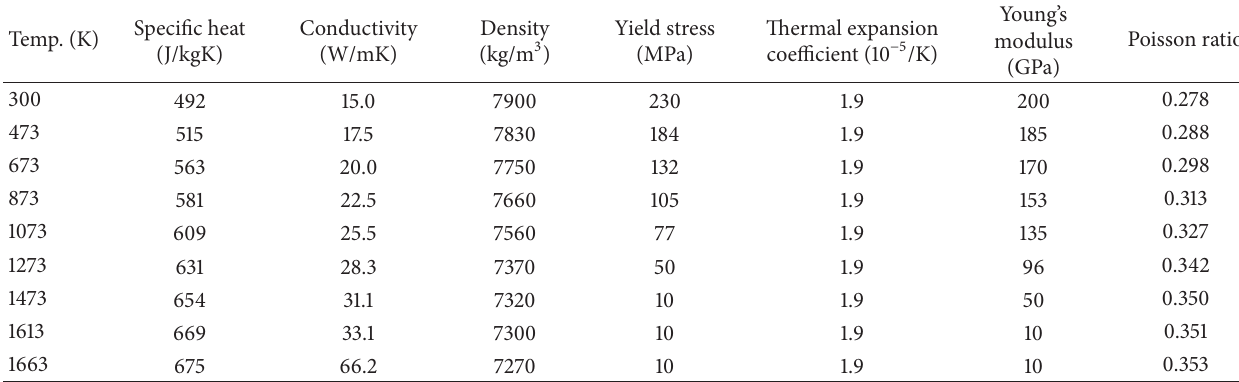
Table 1: Temperature-dependent material properties of austenitic steel.